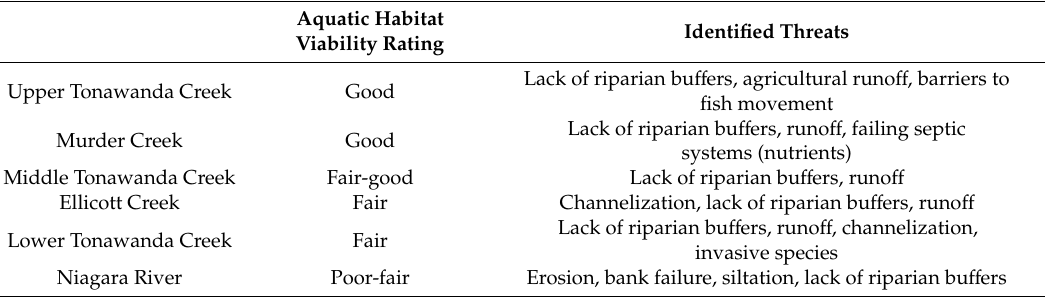
Table 2. Aquatic habitat viability ratings for each of the six study watersheds. Very Good = ecologically desirable status, requires little intervention for maintenance; Good = indicator within acceptable range of variation, some intervention required for maintenance; Fair = outside acceptable range of variation, requires human intervention; Poor = restoration increasingly di ffi cult, may result in extirpation of native species